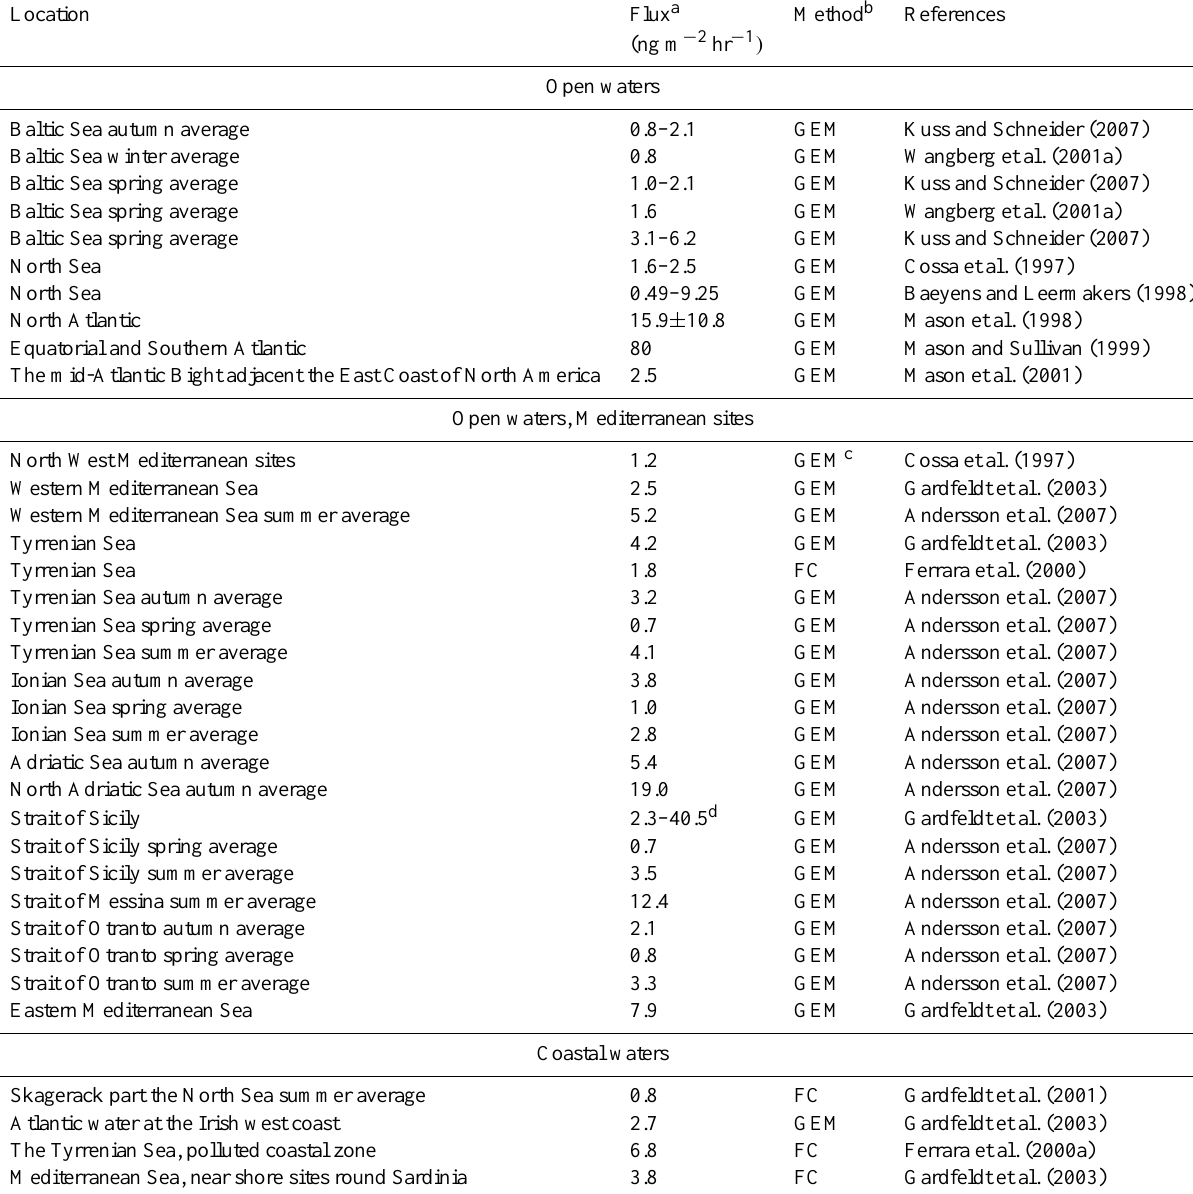
Table 3. Mercury evasion from seawater surface of some aquatic